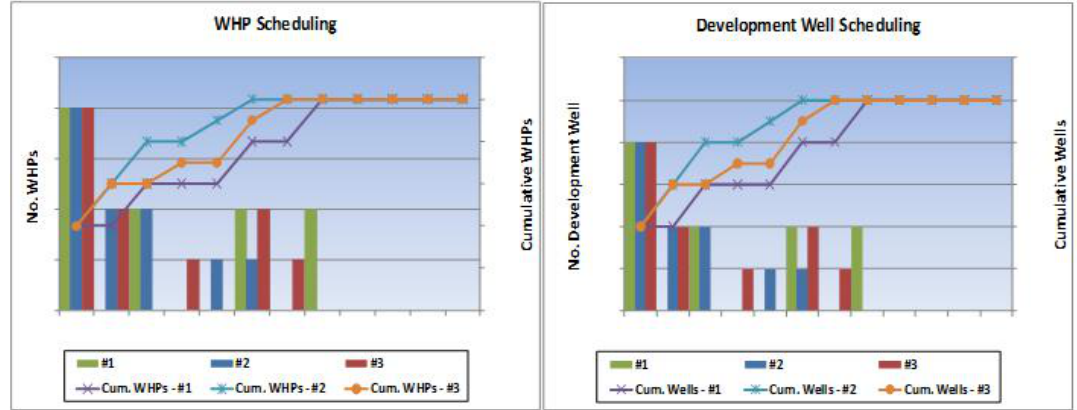
Figure 9—Drilling project sequence and number of required WHP/development